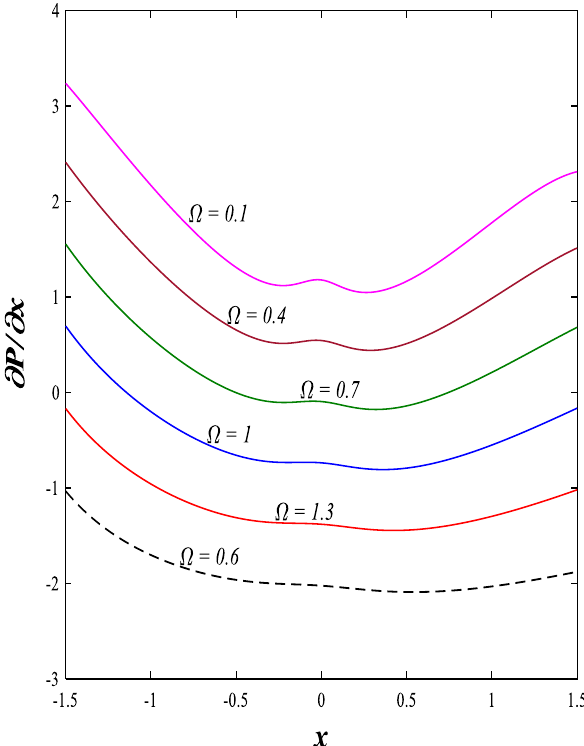
Figure 25. Effect of rotation Ω on the pressure gradients distribution.